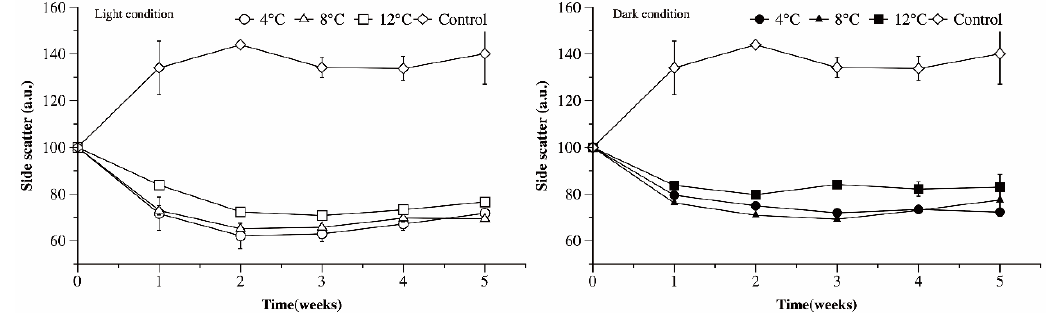
Figure 7. Side scatter, analyzed by FCM, of Ma cells exposed to different temperature and light conditions as a function of time.